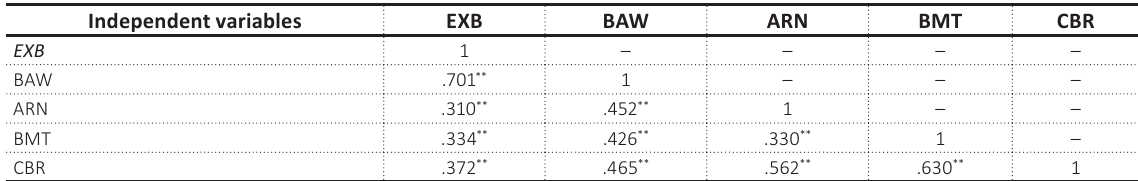
Table 5. Correlation coefficients between independent variables Independent